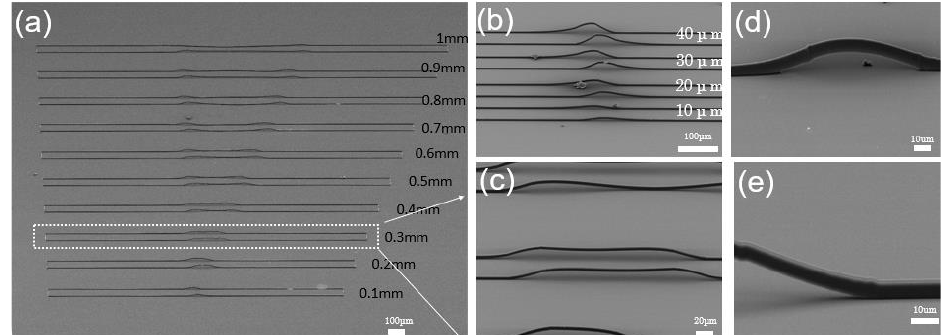
Figure 2. ( a ) SEM images of jumper wires at different lengths. ( b ) Jumper wires with 10 – 40 μm in height. ( c ) Jumper wires with 0.3 mm in length. ( d ) Jumper images with higher multiples. ( e ) Partial magnification of the jumper.